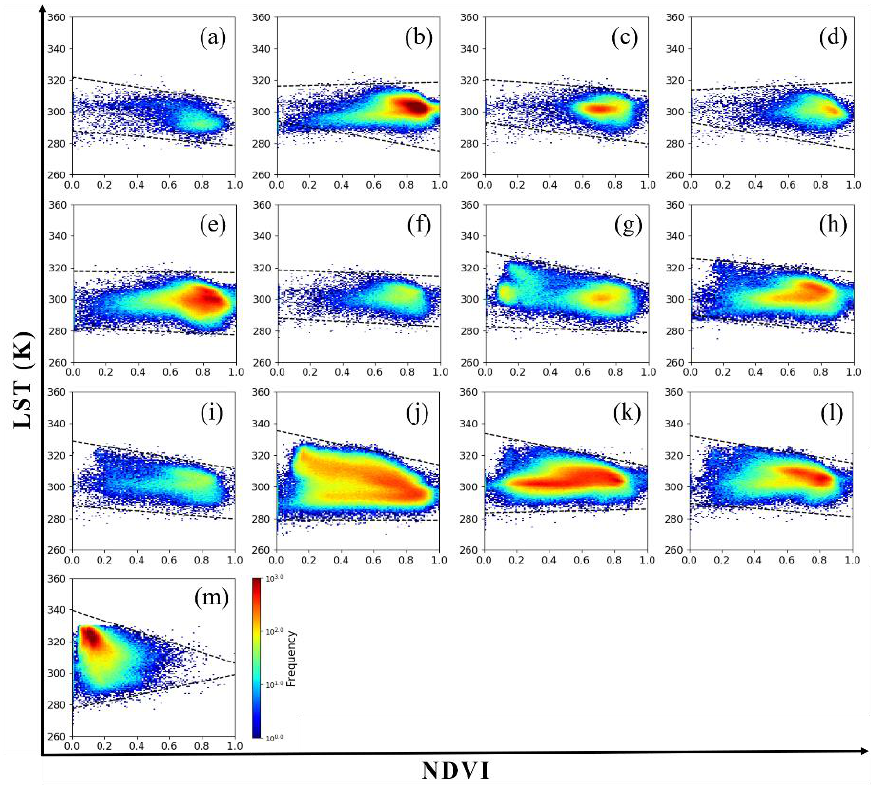
Figure 4. Scatterplots of NDVI and LST on 19 July 2020 for 13 land cover types: ( a ) Evergreen Needleleaf Forest, ( b ) Evergreen Broadleaf Forest, ( c ) Deciduous Needleleaf Forest, ( d ) Deciduous Broadleaf Forest, ( e ) Mixed Forest, ( f ) Closed Shrublands, ( g ) Open Shrublands, ( h ) Woody Savannas, ( i ) Savannas, ( j ) Grasslands, ( k ) Croplands, ( l ) Cropland/Natural Vegetation Mosaic, and ( m ) Barren or Sparsely Vegetated.